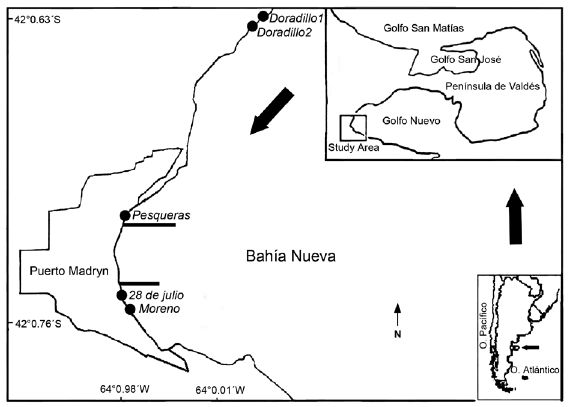
Fig . 1. – Study area showing the collection